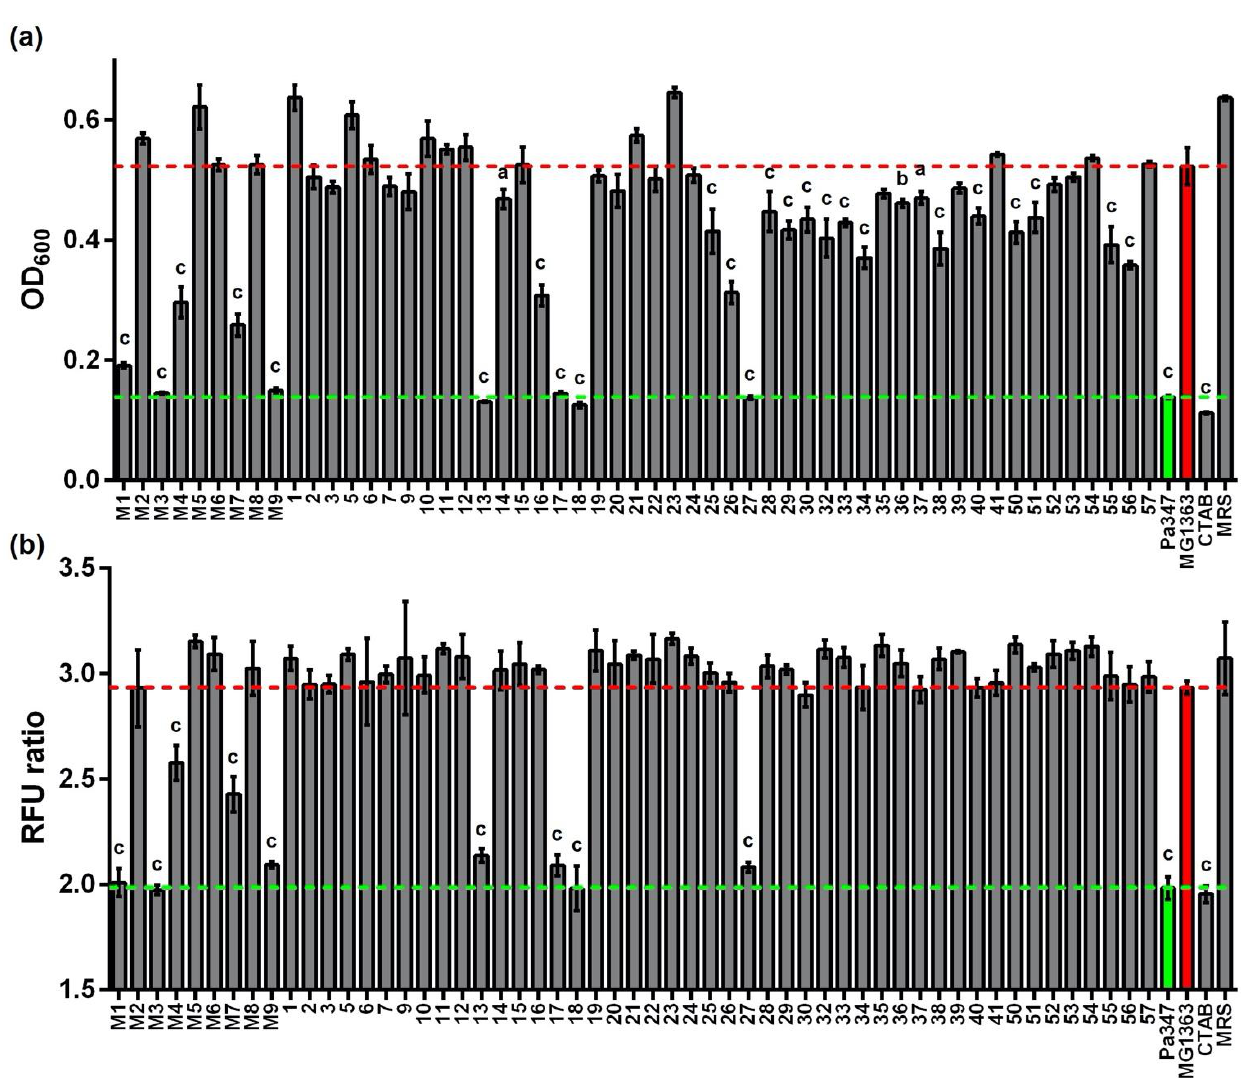
Figure 1. ( a ) Growth inhibitory and ( b ) membrane damaging activity in supernatants of LAB isolated from raw cow’s milk. LAB isolates were grown in 5 mL MRS medium in glass tubes. Activity was measured in culture supernatants after o/N growth using L. monocytogenes EGDe/pNZ-P help -pHluorin as an indicator. Values are OD 600 of the indicator strain (a) or ratio of fluorescence intensity (RFU ratio; emission at 510 nm, b) after excitation at 400 and 470 nm and are mean ± standard deviation (SD) of n = 3 independent experiments. Supernatants of the pediocin producer P. acidilactici 347 (Pa347) and the non-bacteriocin producer L. lactis MG1363 were used as biological controls. The broken red and green lines indicate OD 600 of the positive (i.e., complete inhibition of growth by CTAB) or negative (i.e., sterile MRS medium) controls), respectively. Statistical analysis was performed using one-way ANOVA with the Bonferroni post-test to calculate p -values adjusted for multiple comparisons and values obtained with supernatants of the non-bacteriocin producer L. lactis MG1363 set as the control condition (a: p < 0.05; b: p < 0.01; c: p < 0.001).